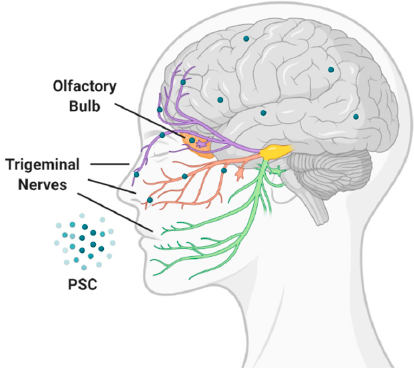
Figure 7. Nose to brain direct administration route of PSC.